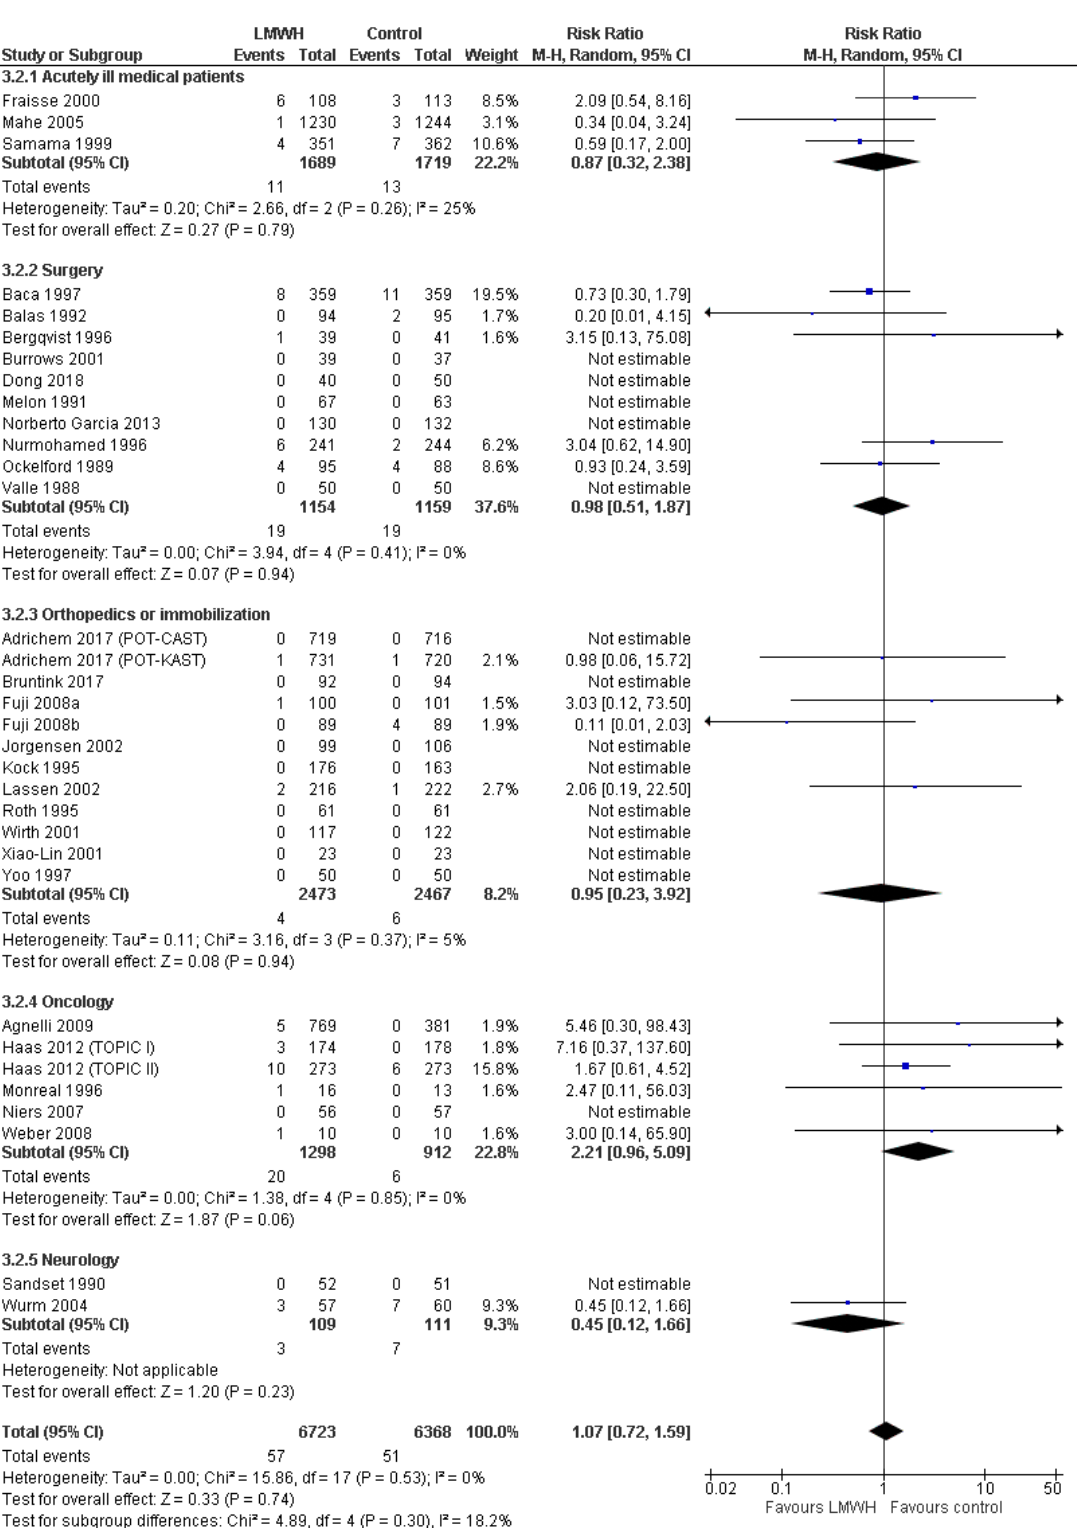
Figure 5. Forest plot of major bleeding. Forest plot of major bleeding at maximal follow-up of LMWH prophylaxis compared to placebo or no treatment, stratified according to patient type. The size of the squares reflects the weight of the trial in the pooled analysis. Horizontal bars represent 95% confidence intervals.